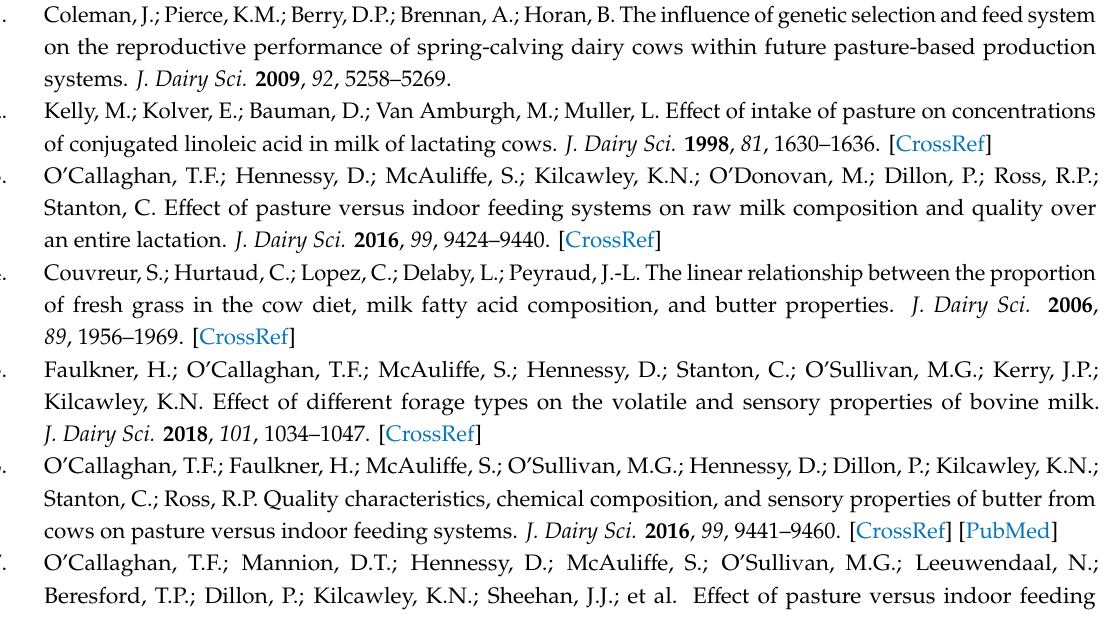
Figure S1: Top 10 fatty acids significantly contributing to observed PCA